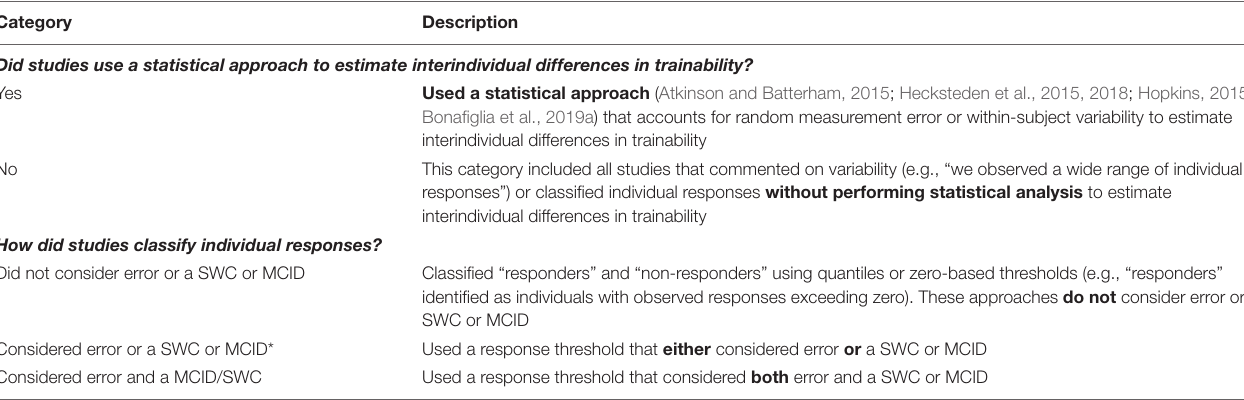
TABLE 2 | Categorization details for the primary